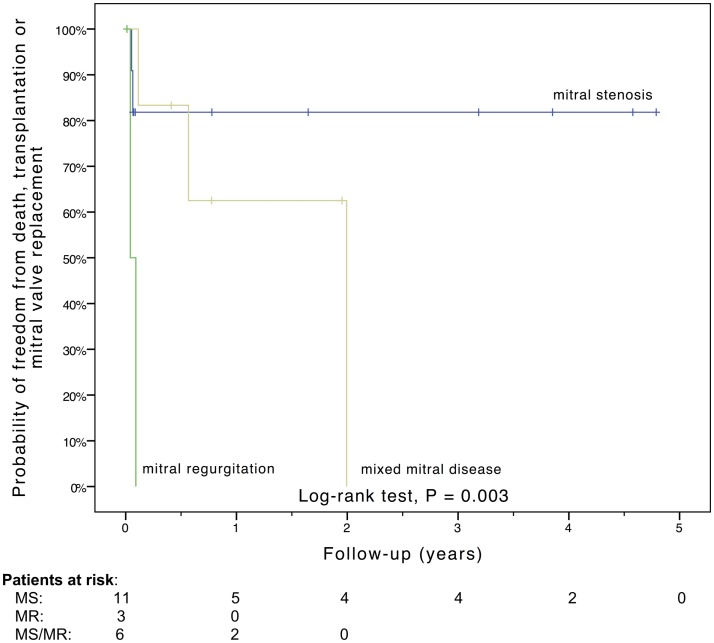
Kaplan–Meier estimate of freedom from death, transplantation, or mitral valve replacement stratified by the mechanism of mitral valve dysfunction. MR, mitral regurgitation; MS, mitral stenosis; MS/MR, mixed mitral disease.